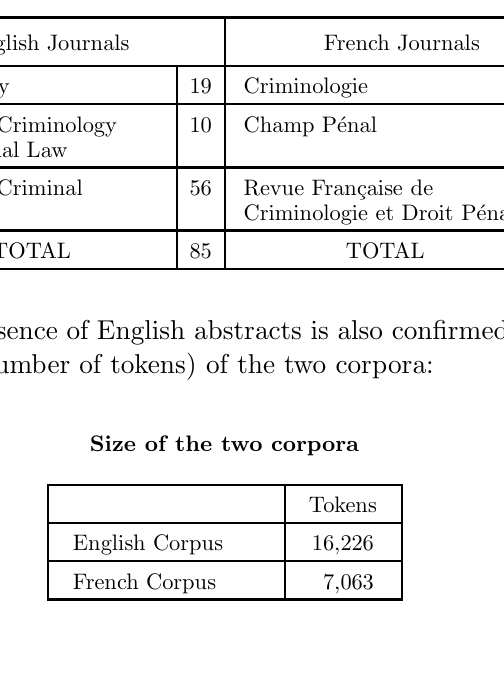
Number of abstracts per journal in the two languages